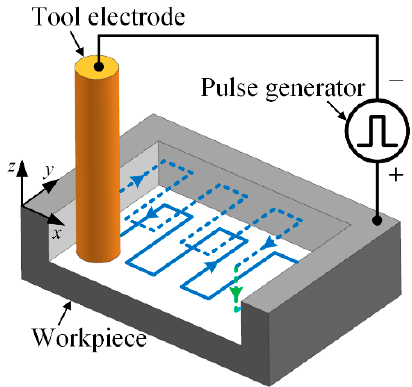
Figure 1. Schematic diagram of micro-EDM milling.